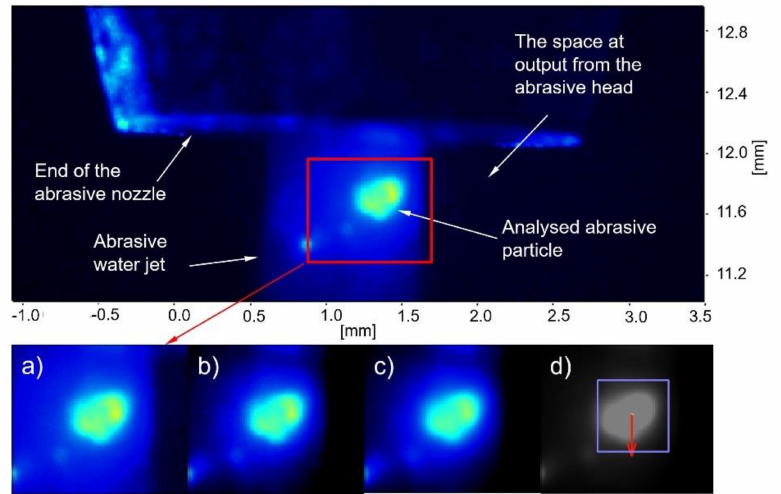
Figure 7. Image processing procedure: ( a ) experimental image; ( b ) background noise reduction; ( c ) averaging of pixel intensities; ( d ) tracking algorithm for abrasive particle velocity